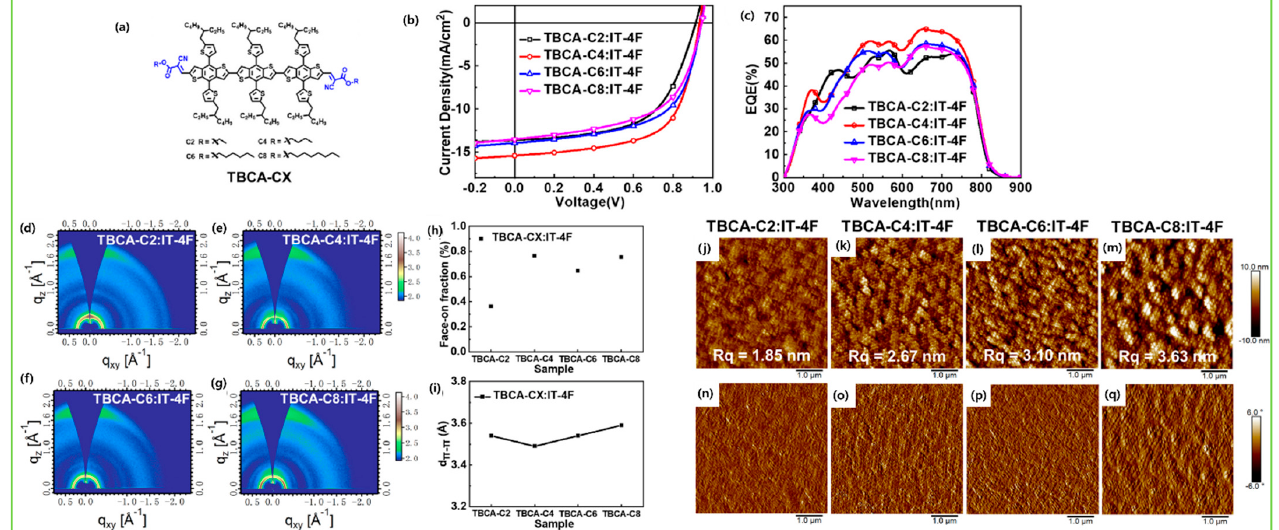
Figure 14. ( a ) Chemical structure of TBCA − CX. ( b ) J-V curves. ( c ) EQE spectra of TBCA − CX: IT − 4F BHJ devices. ( d – g ) Two-dimensional GIWAXS patterns of TBCA − CX: IT − 4F blend films. ( h ) Face-on orientation ratios for the TBCA − CX: IT − 4F blend films. ( i ) Out-of-plane (010) d π – π for the TBCA − CX: IT − 4F blend films. ( j – q ) AFM height and phase images of the TBCA − CX:IT − 4F blend films. Adapted with permission from [121]. Copyright 2022, Elsevier.